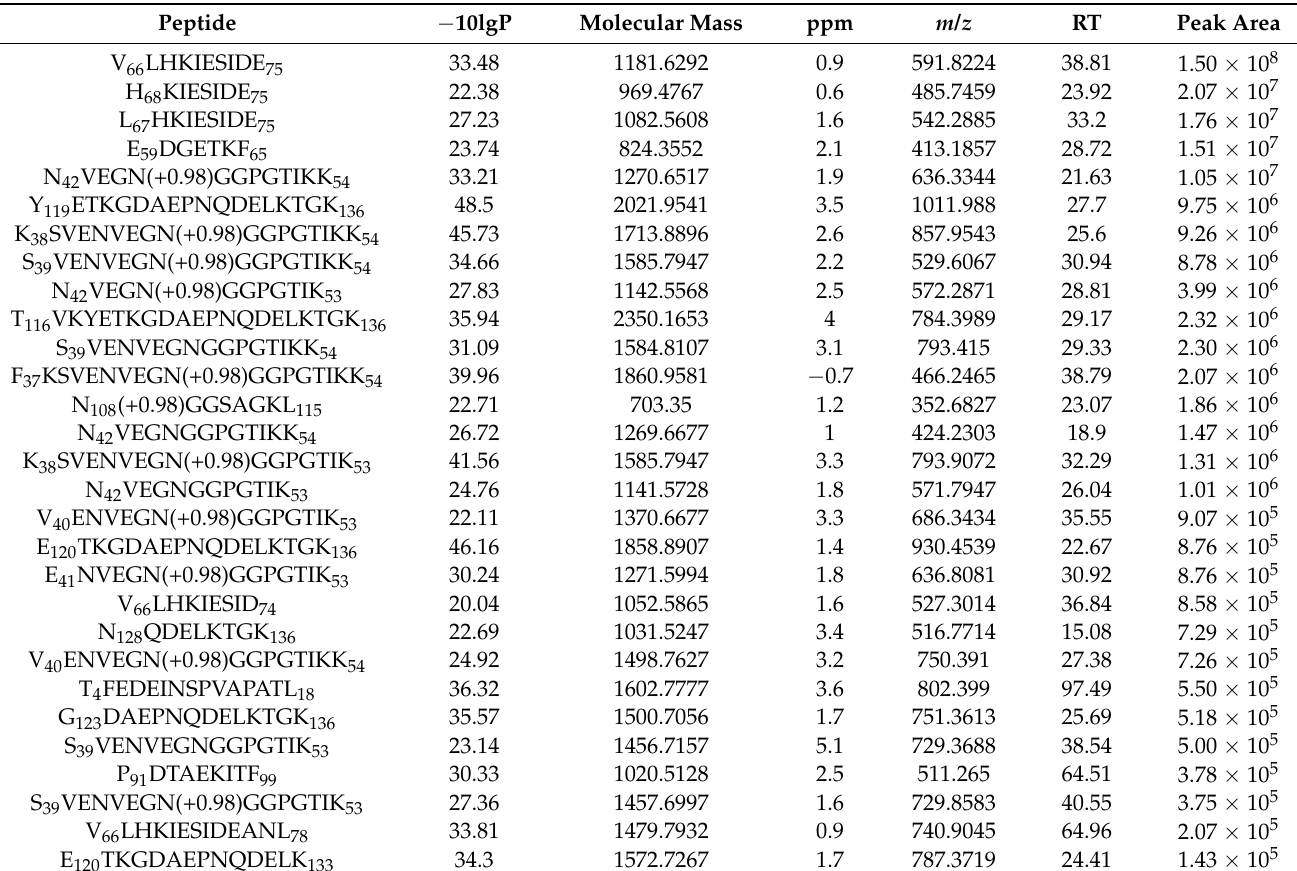
Table 2. Gly m 4 proteolytic fragments identified by LC-MS/MS in basolateral chambers after passing them across the Caco-2 monolayer. The table is ranked based on highest-to-lowest peak area from the top to the bottom. Peptide − 10lgP Molecular Mass ppm m/z RT Peak